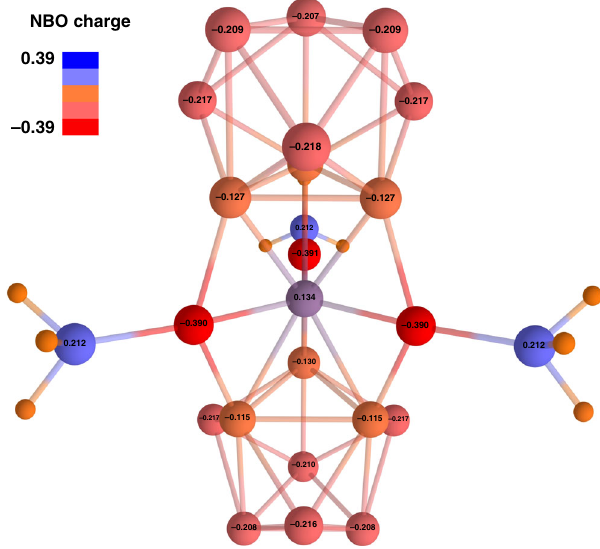
Fig. 4 The charge distribution calculated via NBO method. Positive and negative charges are illustrated in a scale form blue to red, respectively. Lines between atoms help in visualization and do not represent 2c – 2e bonds here and elsewhere. Charges of hydrogen atoms are omitted for